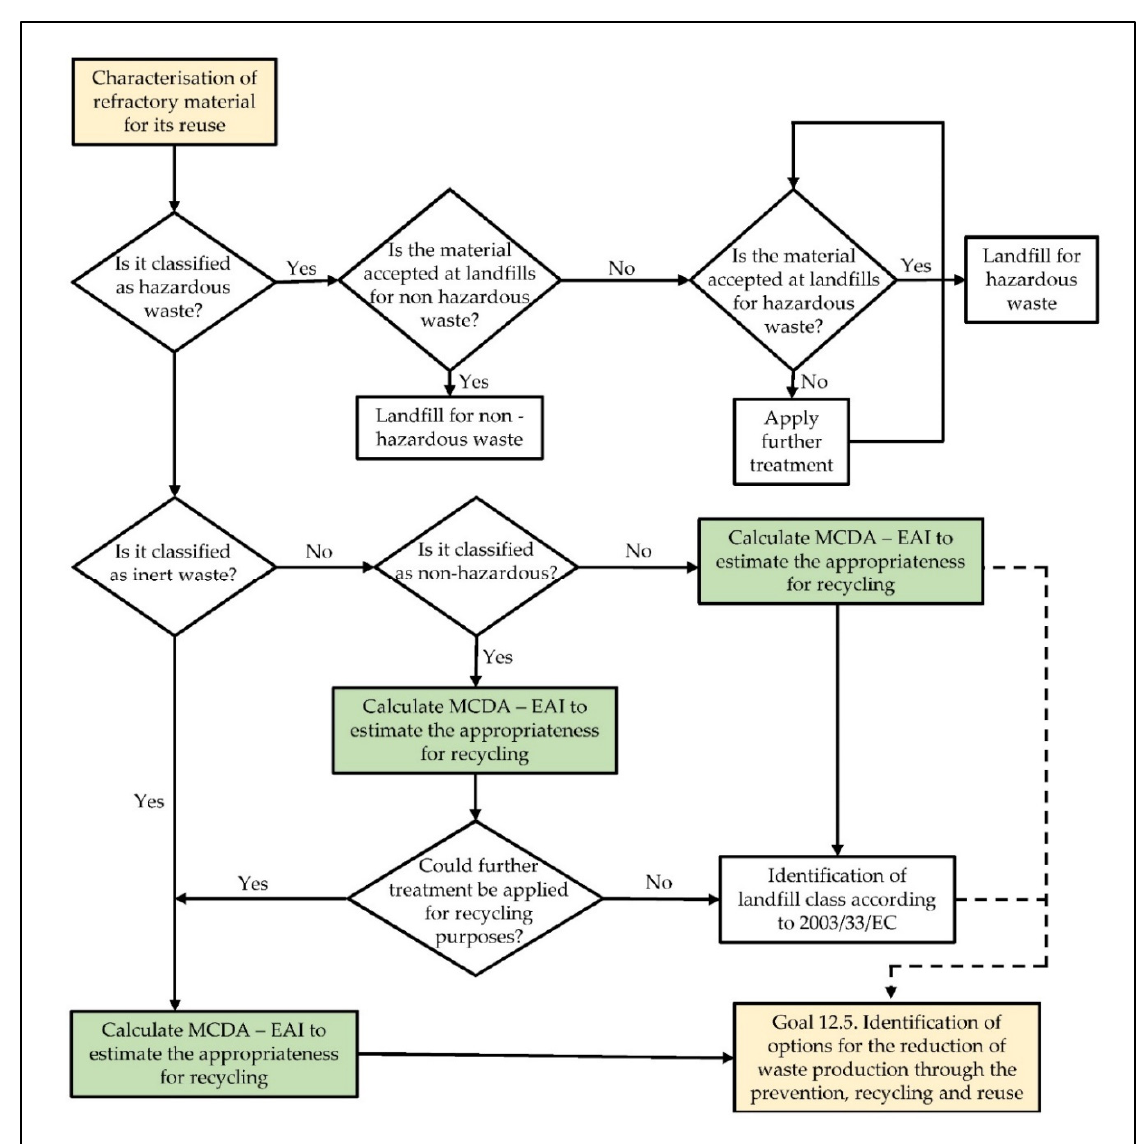
Figure 1. The proposed MCDA (multicriteria decision analysis) procedure and adopted EU frame- work [15] in the investigation of achievement SDGs (sustainable development goals) for the refractory spent material (EAI—environmental appropriateness index).